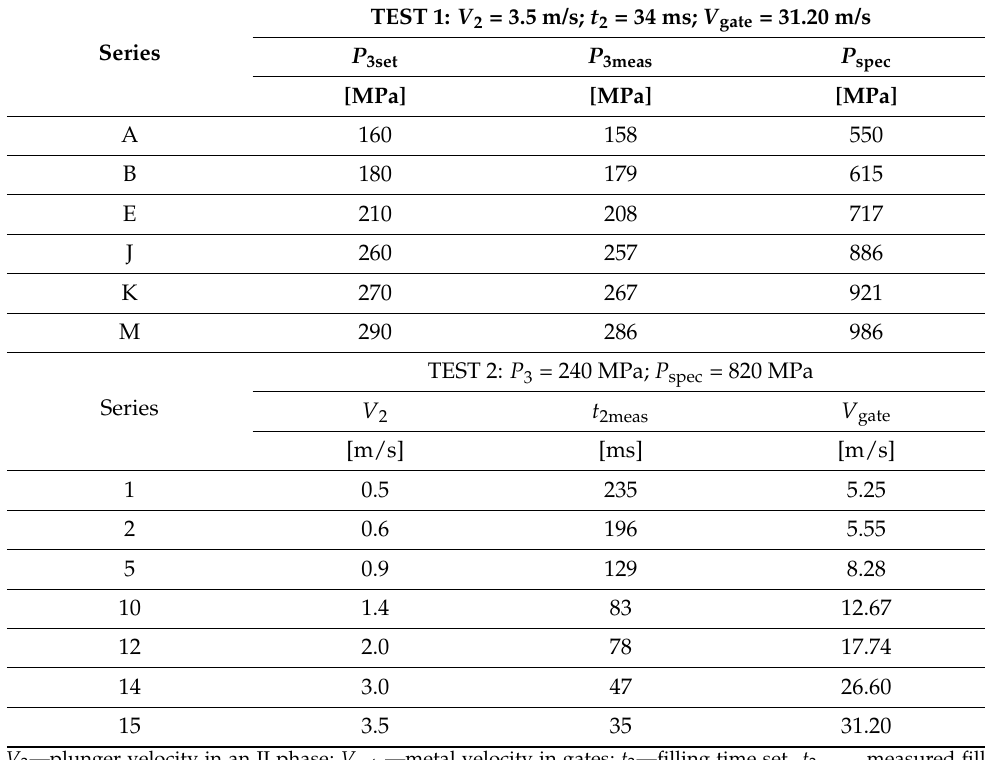
Table 2. Process parameters for obtaining selected test castings.